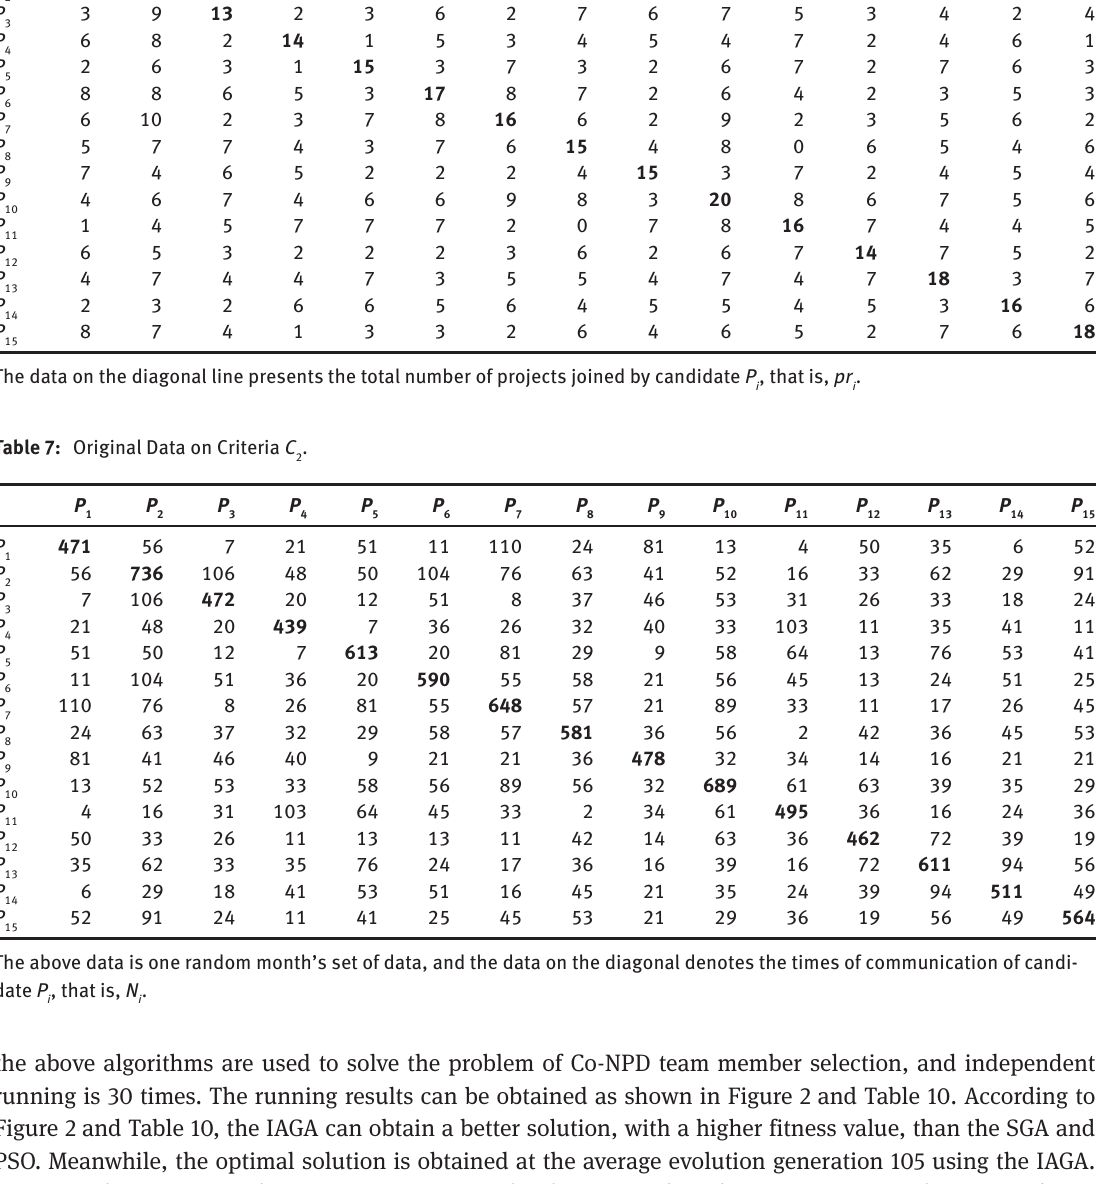
Table 6: Original Data on Criteria C